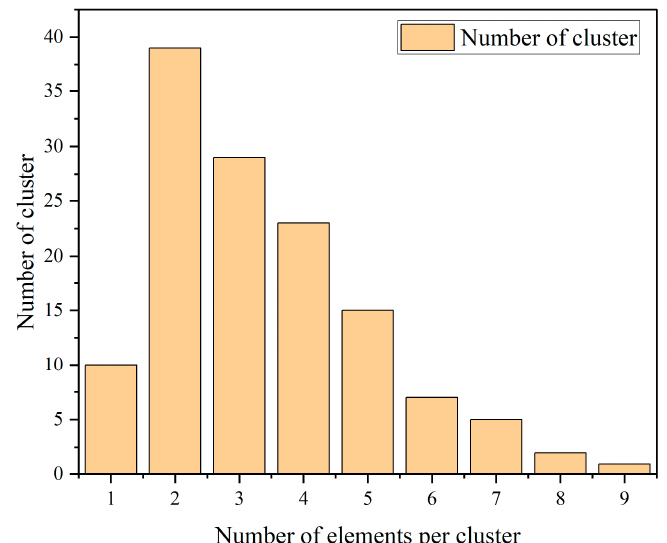
Figure 11. The number of elements within clusters.